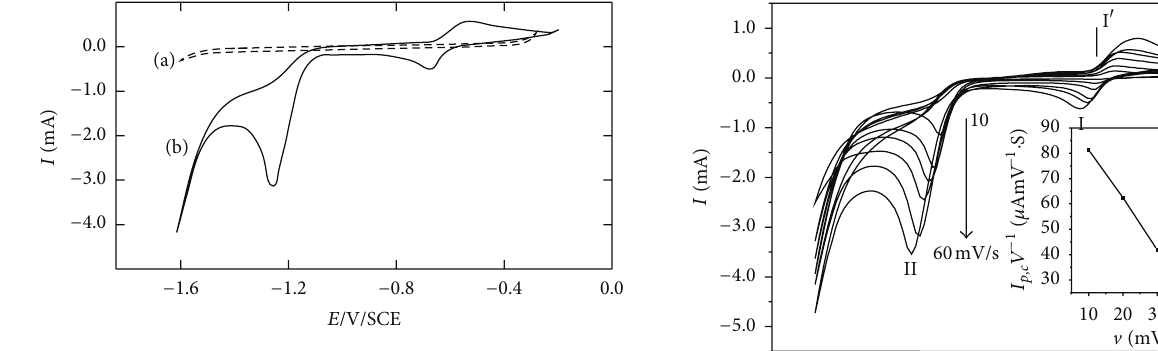
Figure 3: Cyclic voltammograms recorded with a: (a) thin film- electrode without BP; (b) the thinfilm electrode containing 20mM of BP in contact with 0.1MLiClO 4 aqueous solution buffered with a 0.1mol/L phosphate buffer at pH = 1. Besides the redox probe, the organic phase contains 0.1M tetrabuthylammonium perchlorate (Bu 4 NClO 4 ) as an organic electrolyte. Scan rate was V = 20 mV/s.